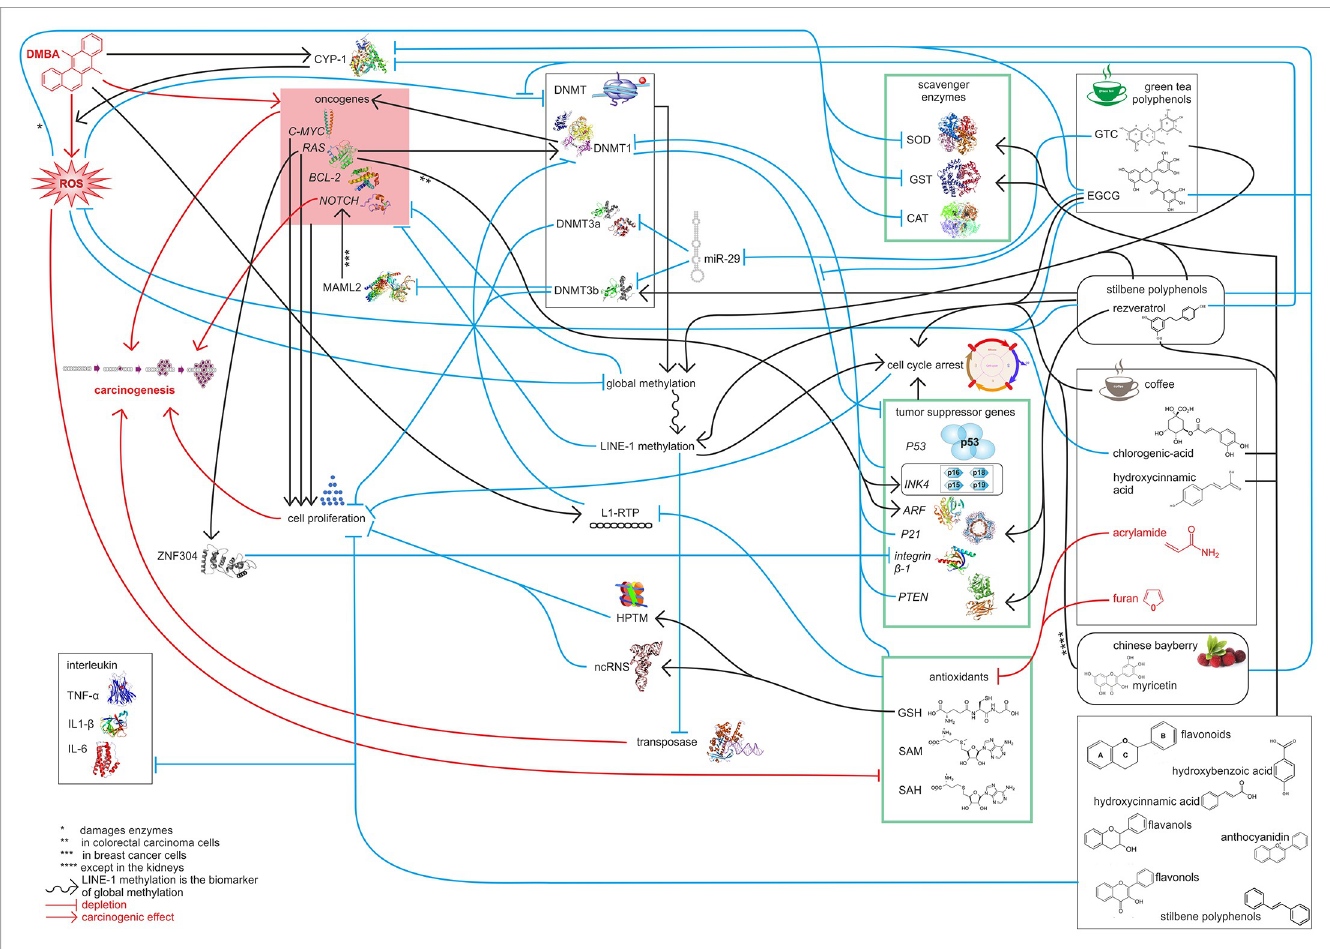
Fig 4. Summary of molecular mechanisms and signal transductions. The harmful effects induced signal transductions and the chemopreventive effects too influence the LINE-1 methylation pattern.